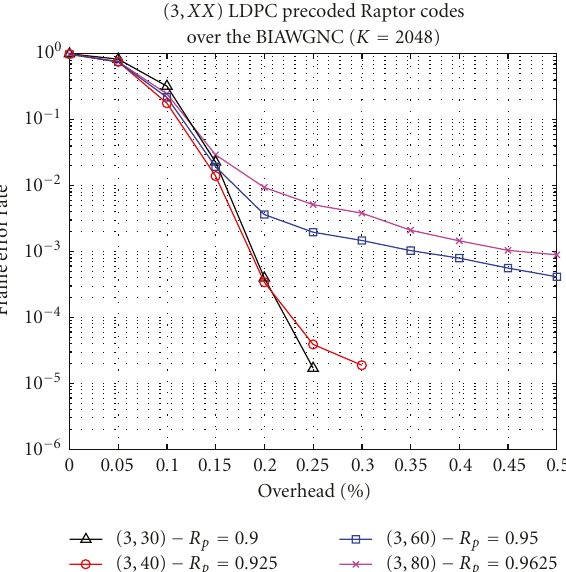
Figure 8: Performance of LDPC precoded Raptor codes of size K = 2048. The lowest rates R = 0 . 9 and R p = 0 . 925 show good performance, whereas the Raptor codes with precodes of higher rates exhibit a severe error